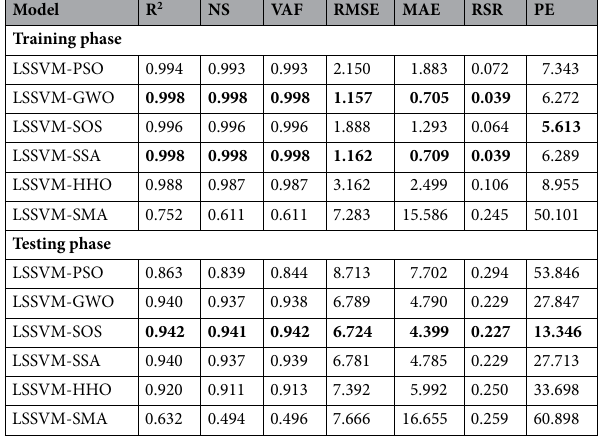
Table 4. Statistical analyses of the proposed models. Significant values are in